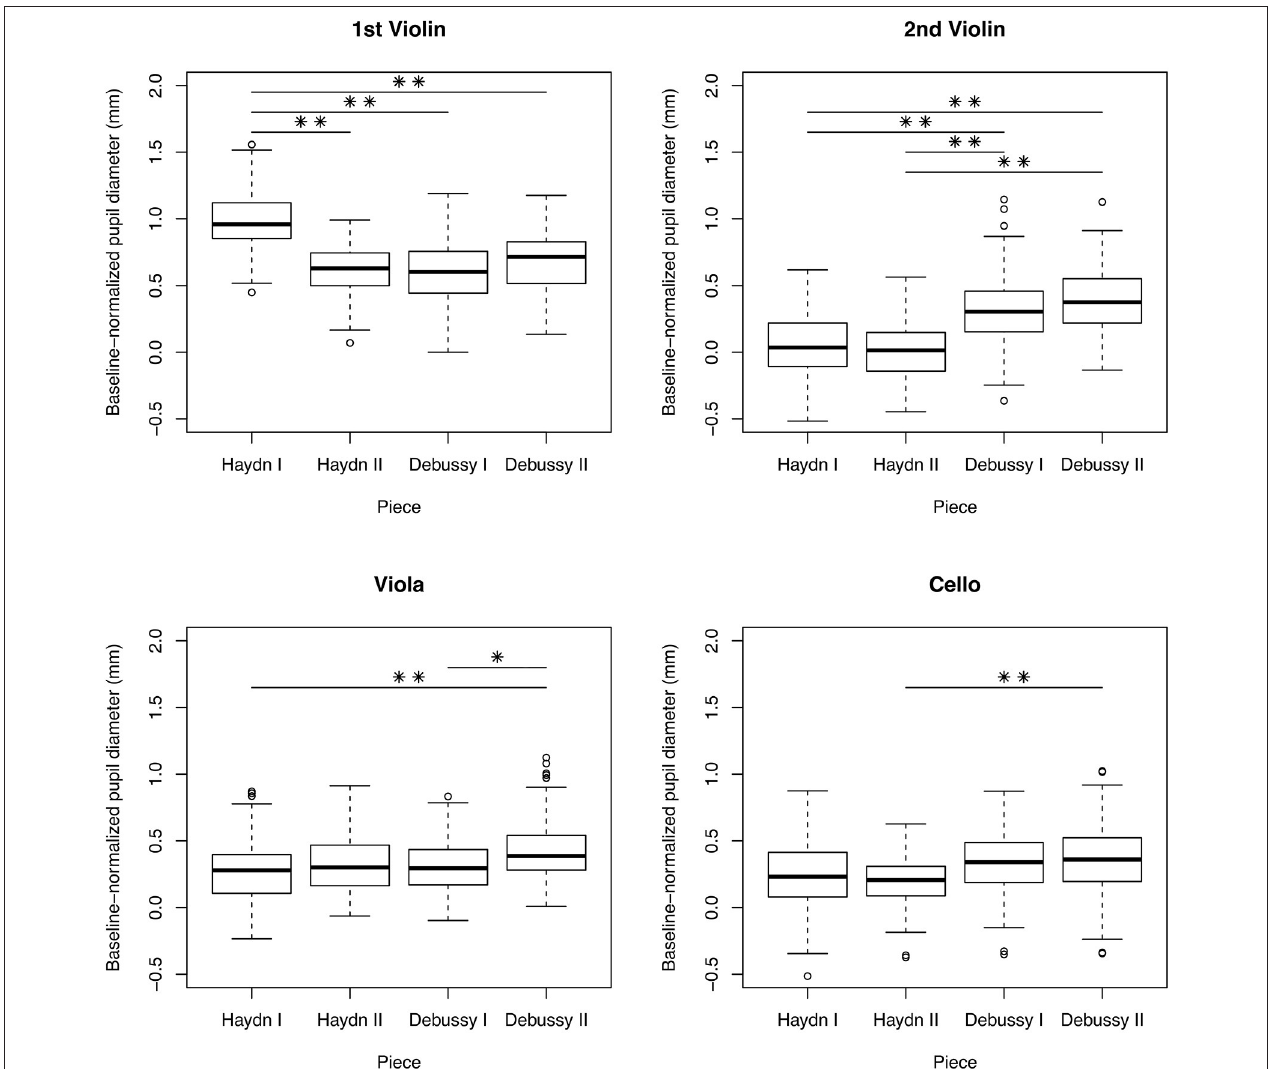
FIGURE 3 | Boxplots showing pupil diameters across concert performances for each musician. Note that the violinists switched places for the Debussy pieces, so the 1st Violin played the 2nd Violin part and vice versa. ** p < 0.001, * p <